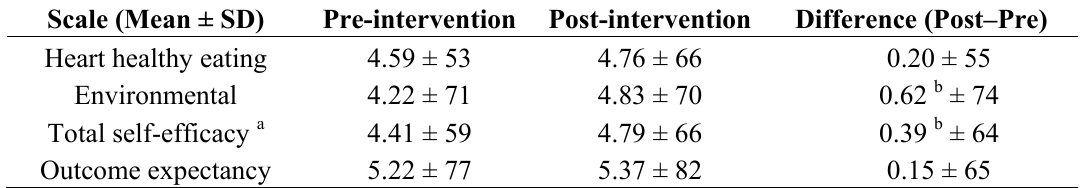
Table 6. Descriptive summary of Heart Healthy Eating Self-efficacy scale and